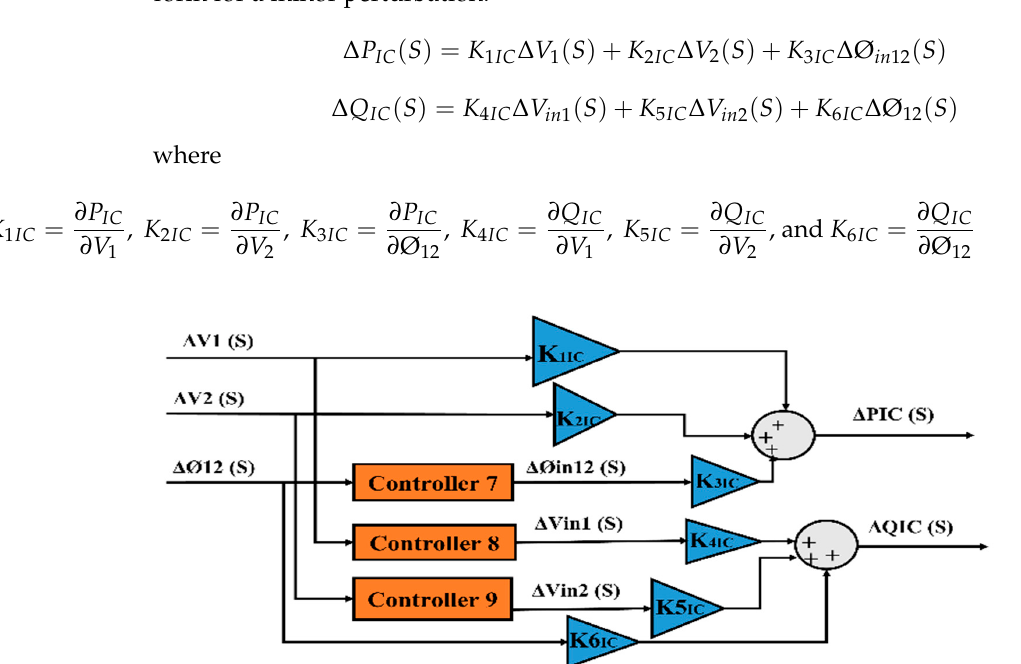
Figure 7. Transfer function block diagram of AC line.